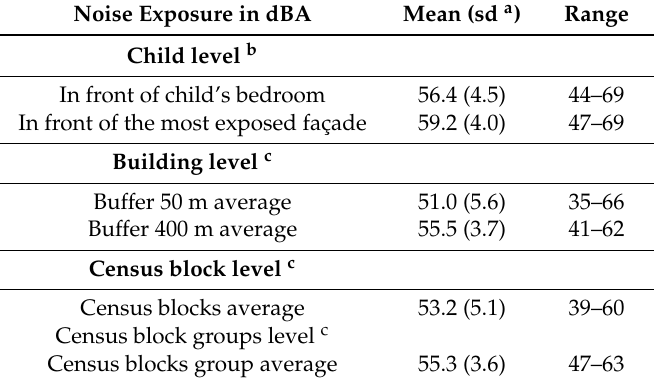
Table 2. Outdoor noise exposure level at the child, building, census block and the census block group levels ( n =